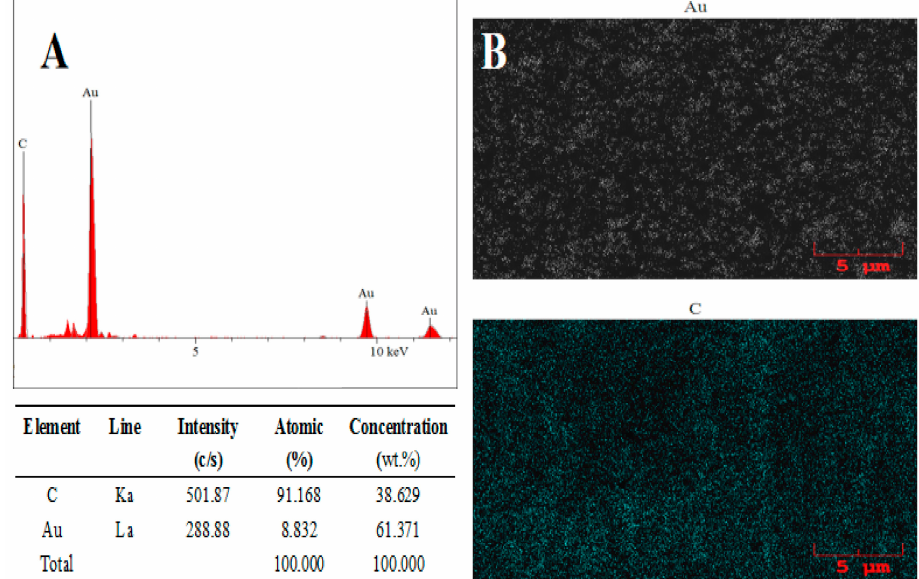
Figure 4. ( A ) EDX spectrum of AuNPs/AB − DHP/GCE. ( B ) EDX spectral mapping of the carbon (white) and gold (blue) at the same location.